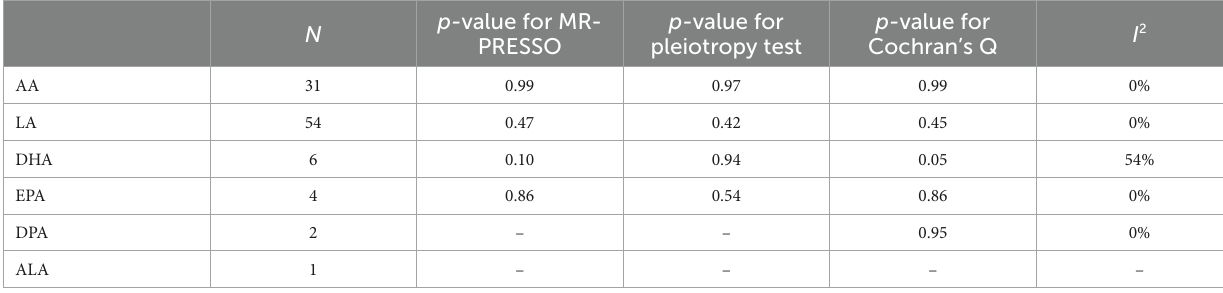
TABLE 3 Results of sensitivity